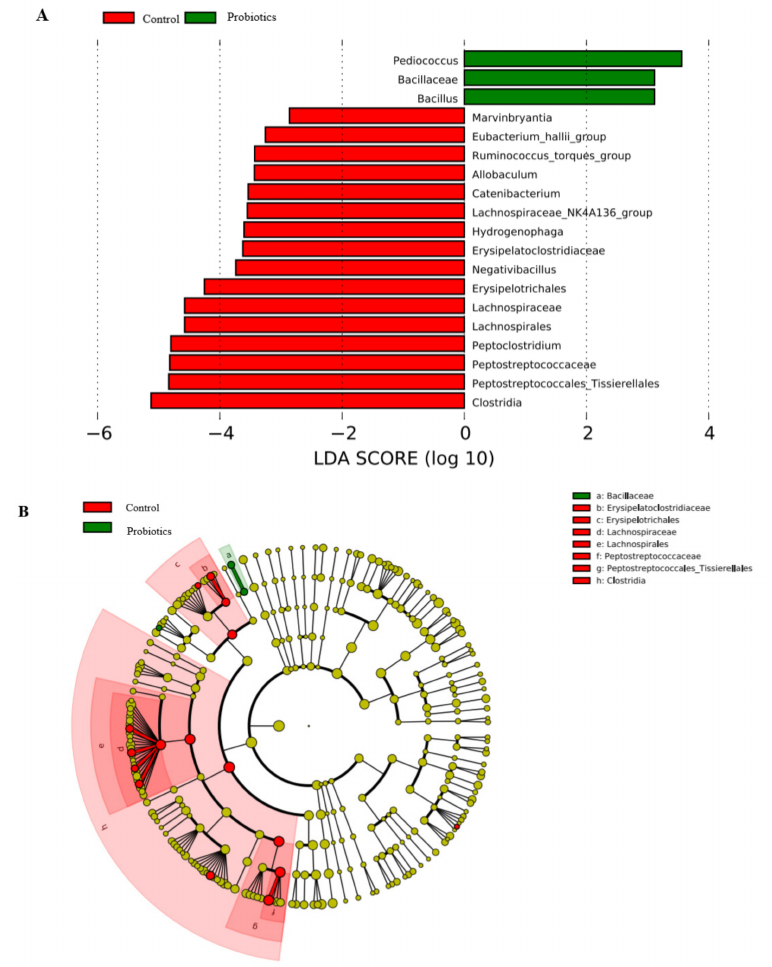
Figure 5. LEFSe difference analysis. ( A ) LDA scores for microbial taxa with significant roles in both groups. ( B ) 16S rRNA sequencing analysis of differences in functional gene abundance in the guts of cats in the two groups.